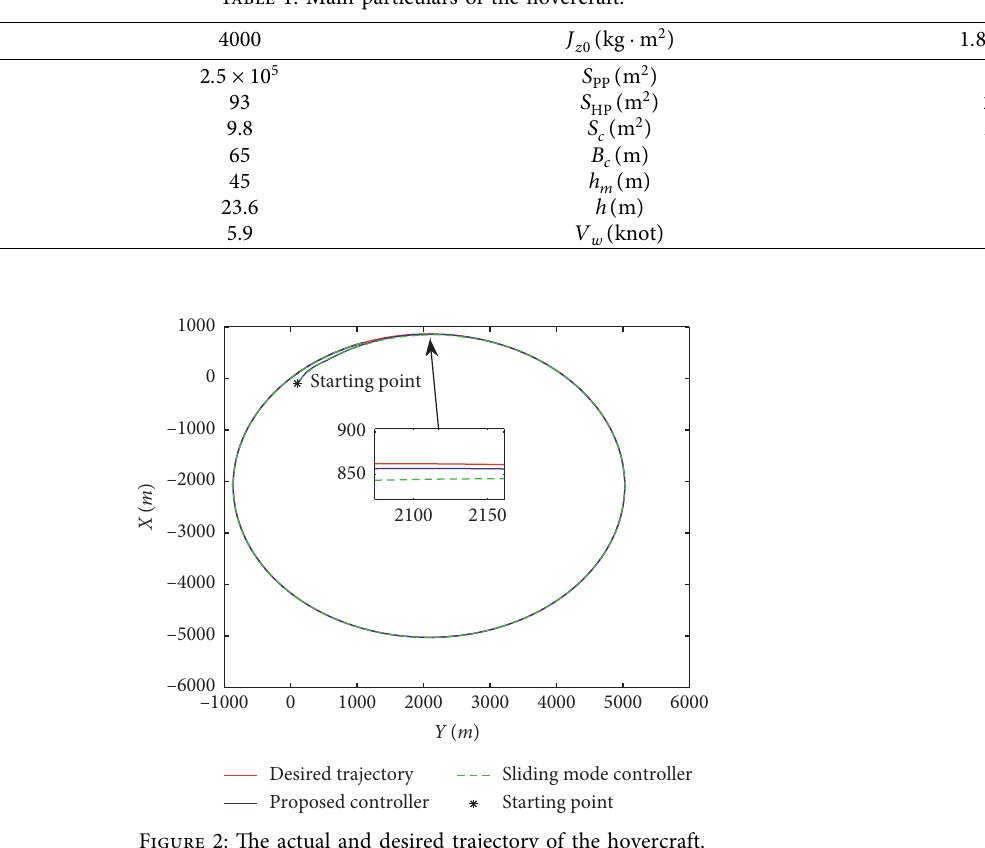
Table 1: Main particulars of the hovercraft.